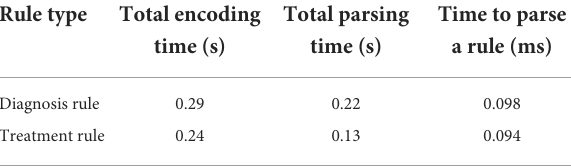
TABLE 6 Runtimes for encoding and parsing diagnosis (total of 2,192 rules) and action rules (total of